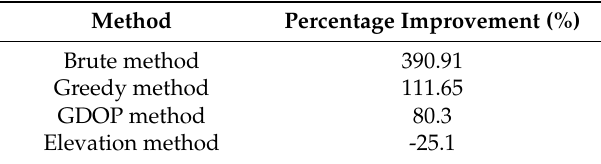
Table 11. Percentage improvement in running rate compared to other